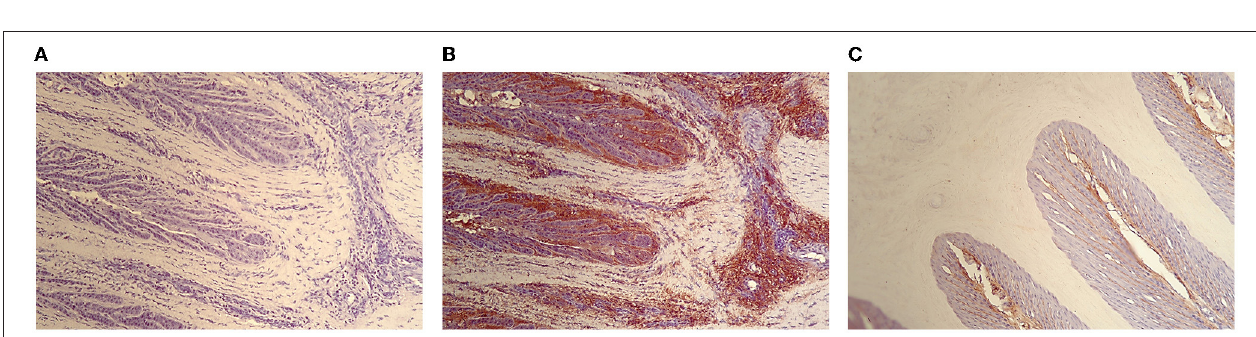
Frontiers in Veterinary Science |